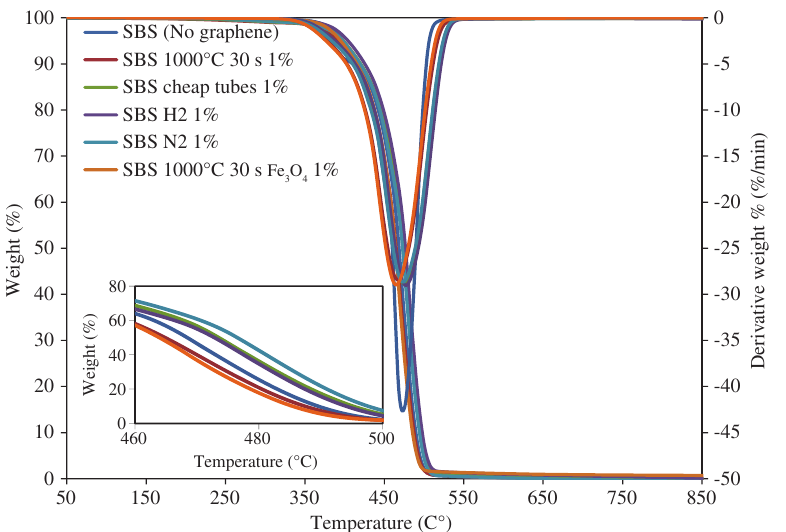
Figure 9 TGA mass v ’s temperature with first derivative of SBS and graphene (1%) composites created with GT and CT (listed in order of temperature of decomposition).